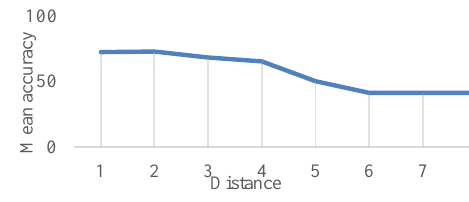
Figure 5. Mean accuracy versus the distance between the frames in differentiation layer.